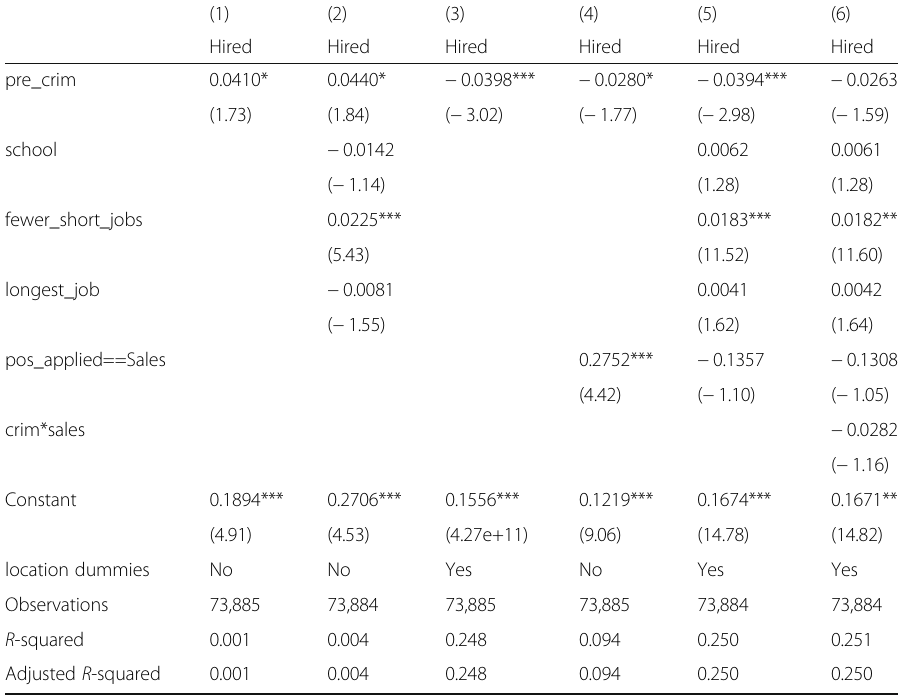
Table 3 Correlates of hiring rates (customer service and